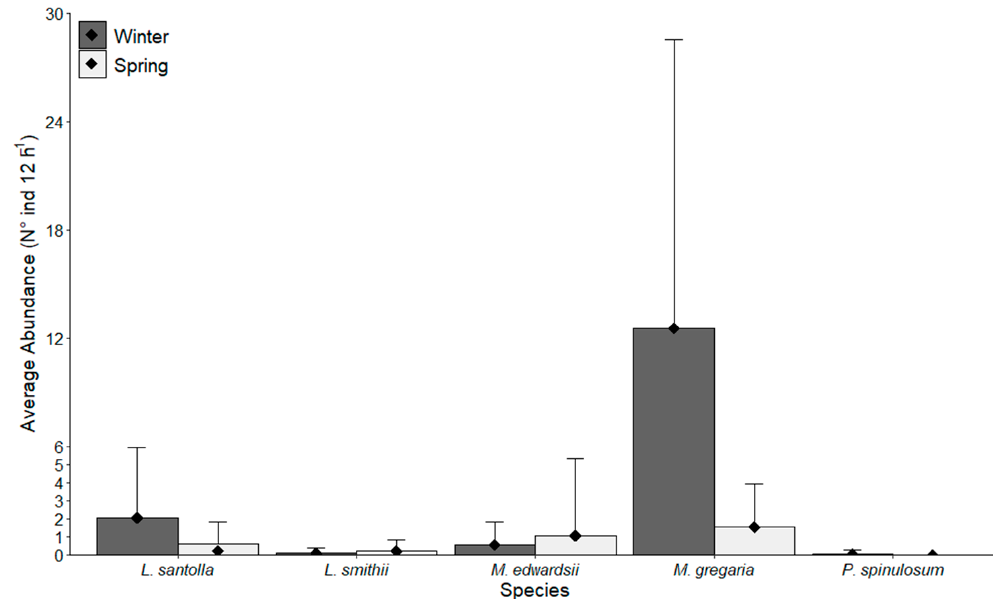
Figure 3. Mean ( ± standard deviation) seasonal abundance of the decapods associated with the southern king crab fishery. Figure 3. Mean (±standard deviation) seasonal abundance of the decapods associated with the Black rhombuses correspond to the mean abundance estimated by GLM. southern king crab fishery. Black rhombuses correspond to the mean abundance estimated by GLM.